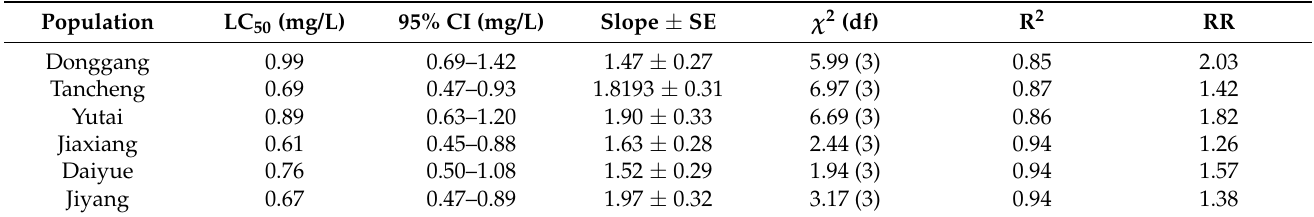
Table 9. Sensitivity to triflumezopyrim in six L. striatellus populations in Shandong